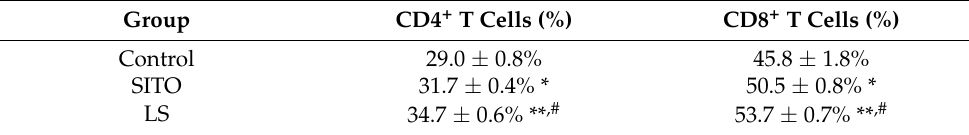
Table 2. Percentages of CD4 + and CD8 + T-lymphocyte subsets in the spleens of the control, β - sitosterol (SITO)-, and liposomal β -sitosterol (LS)-treated mice. Percentage of CD4+/CD8+ T- lymphocyte subsets expressed as the means ± SE. * p < 0.05 and ** p < 0.01 as compared to that of the control. Significant differences between SITO and LS were expressed as # p < 0.05.